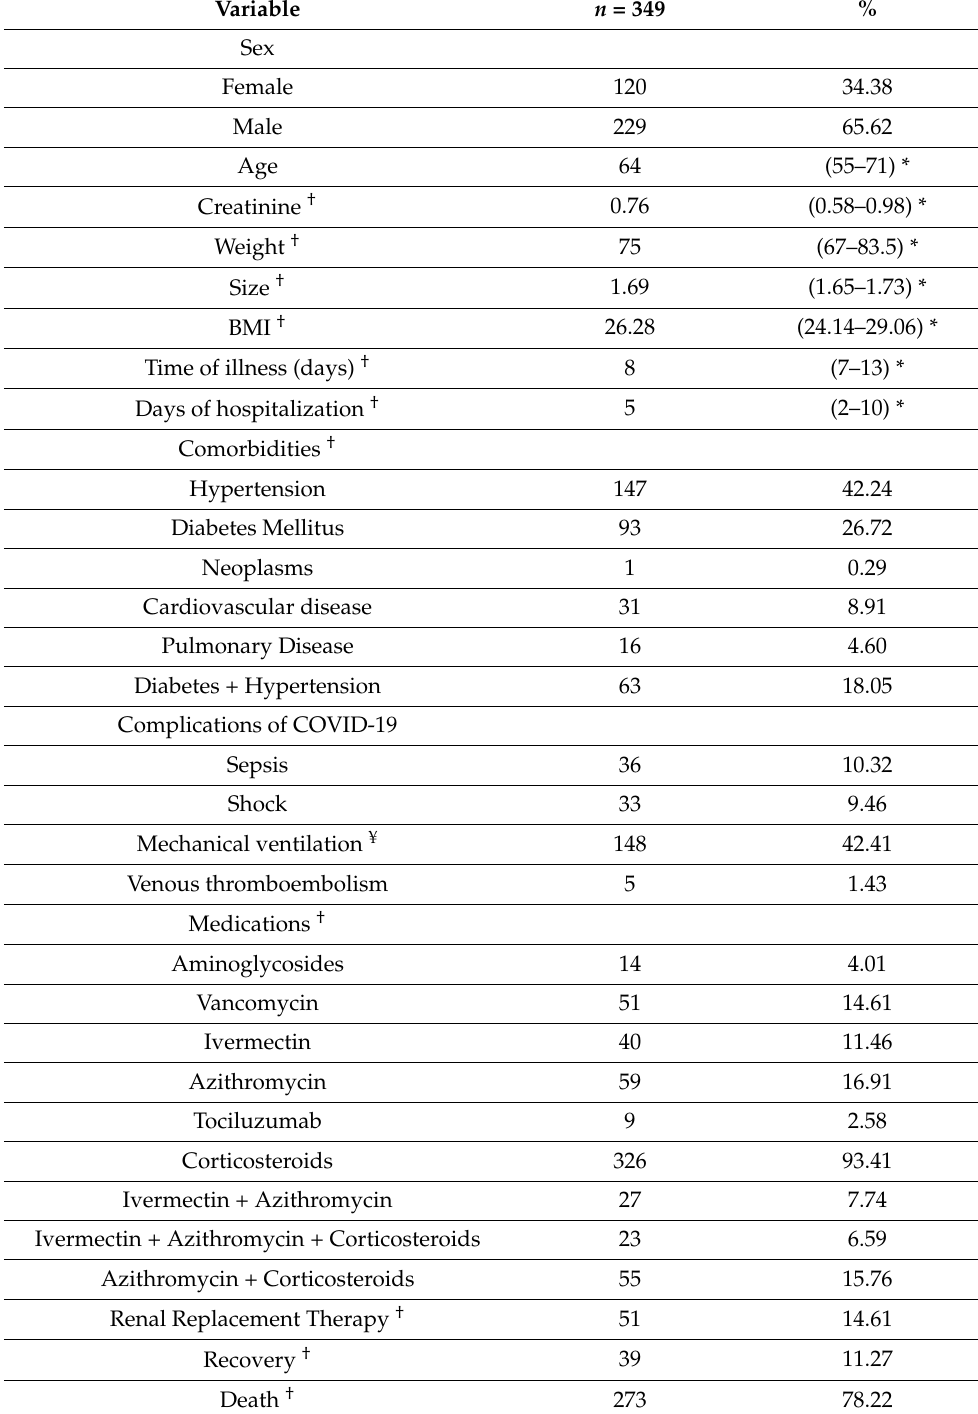
Table 1. Sociodemographic and clinical characteristics of patients infected with SARS-CoV-2 treated at Hospital EsSalud II